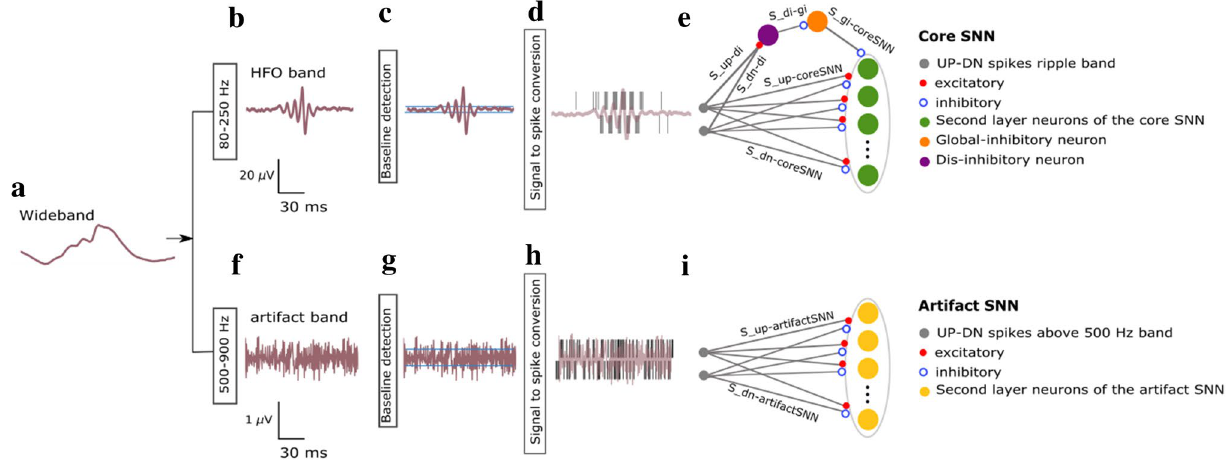
Figure 1. HFO detection scheme. The HFO detector performs three preprocessing stages before sending the data to the SNN. The preprocessing stages are filtering, baseline detection, and converting the analog signal into spikes. ( a ) The EEG signal is filtered in the ripple band (80–250 Hz) ( b ) and 500–900 Hz above the fast ripple band ( f ). ( c , g ) In the baseline detection stage, the background noise of each signal is used to set the signal-to-spike threshold. ( d , h ) The signal-to-spike conversion algorithm converts each analog signal into two streams of digital outputs: UP and DN spikes. ( e ) The core SNN architecture for HFO detection consists of input neurons (grey) receiving the input UP-DN spikes from the filtered signal in the ripple band. These inputs project to a second layer of neurons (green) and to a dis-inhibitory neuron (purple). This neuron projects inhibitory synapses to a global-inhibitory neuron (orange), which is continuously inhibiting the second layer neurons. The synapses of the projections are excitatory (positive, red) or inhibitory (negative, blue). The role of the interneuron and the inhibitory neuron is to avoid the false detection of sharp transients 32 . When enough neurons in this layer are activated, they elicit spikes, indicating an EoI. ( i ) The artifact rejection stage of the SNN consists of input neurons (grey) receiving the input UP-DN spikes from the filtered signal above 500 Hz. These inputs project to a second layer of neurons (yellow). When enough neurons in this layer are activated, they elicit spikes, indicating an artifact’s presence. When the neurons in the core SNN (green) are active simultaneously as the neurons in the artifact SNN (yellow), the EoI is rejected. Conversely, when the neurons in the core SNN (green) are active, and the neurons in the artifact SNN (yellow) are silent, the EEG SNN classifies the EoI as